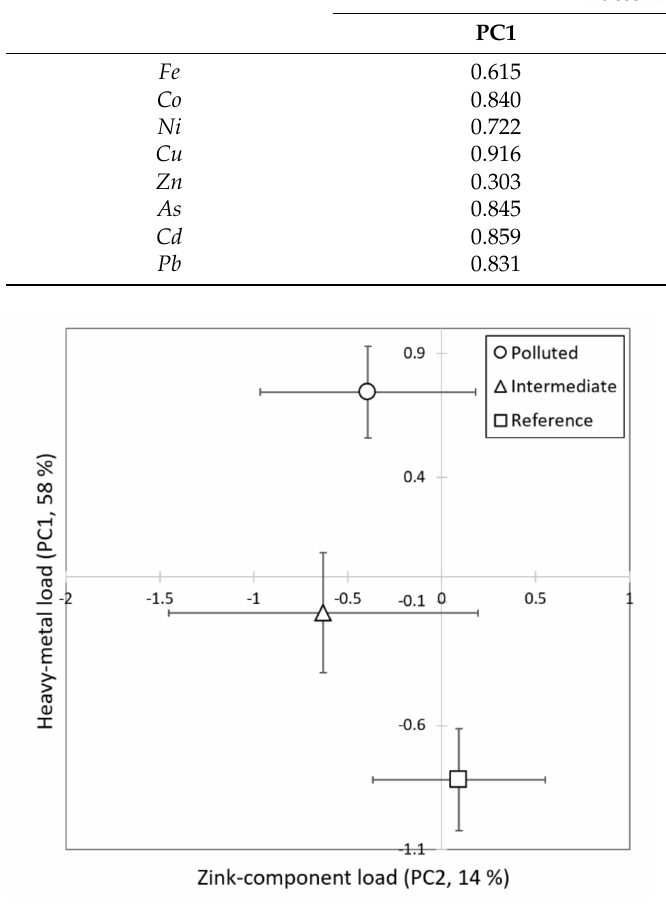
Figure 3. Mean heavy-metal load factors (PC1 and PC2 ± 95% CI) in the pollution zones. All zones differed significantly from each other in PC1 but not in